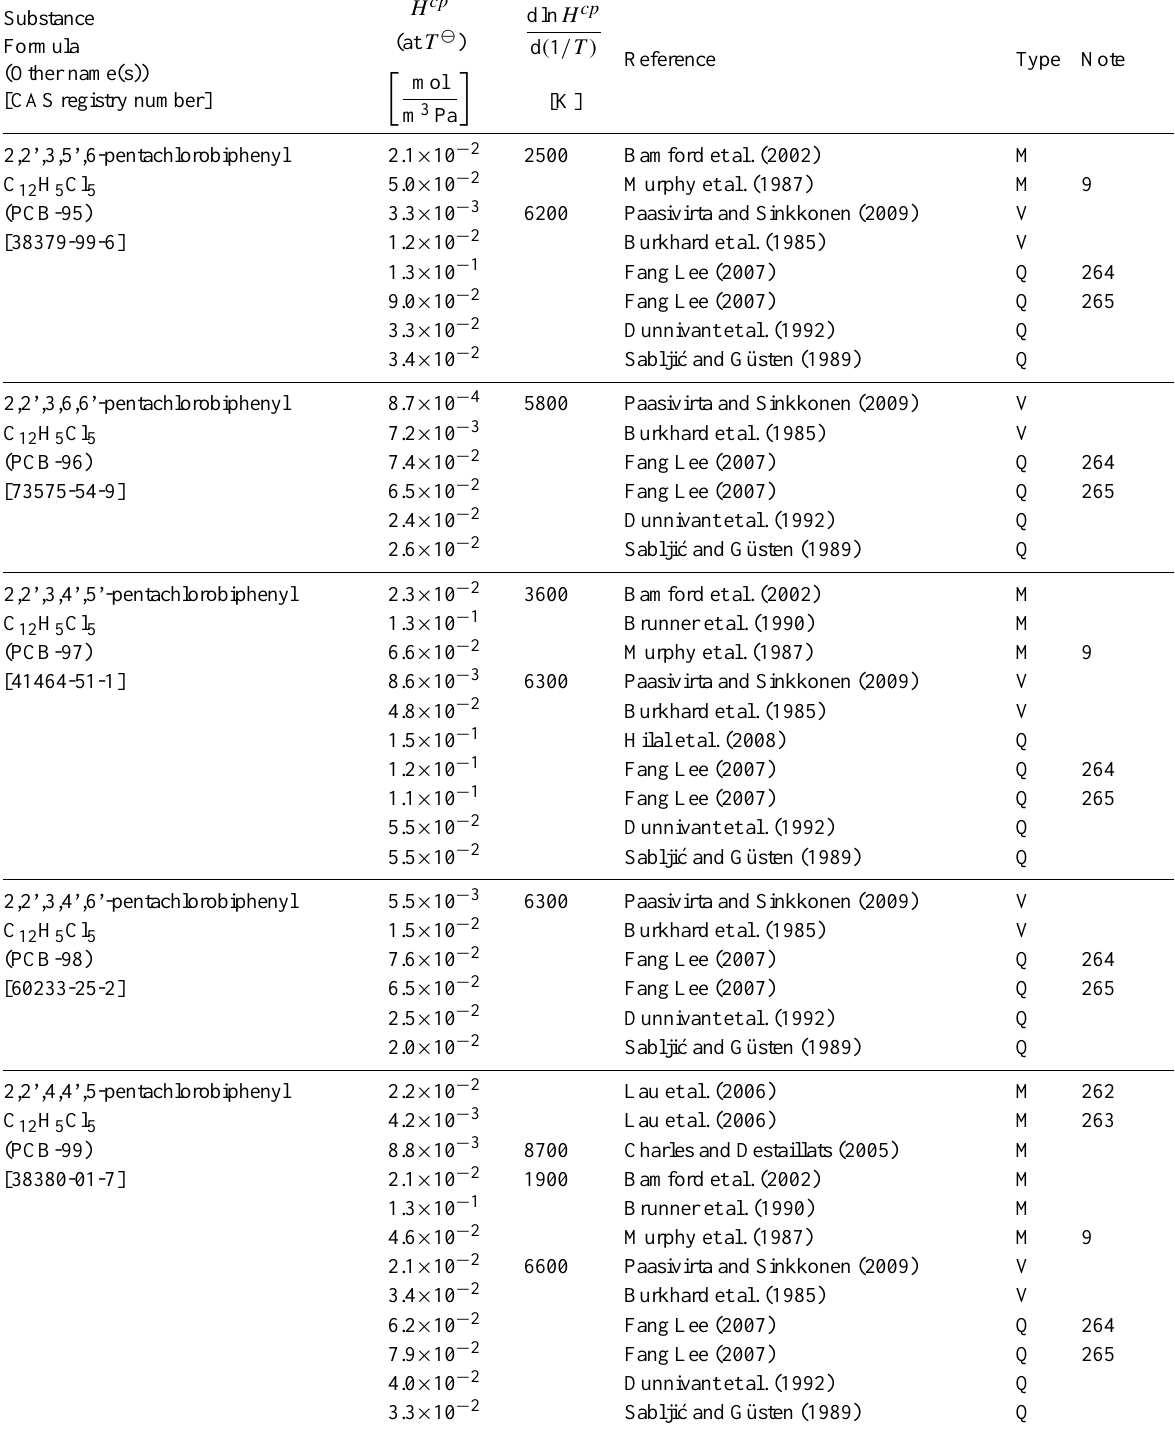
Table 6: Henry’s law constants for water as solvent